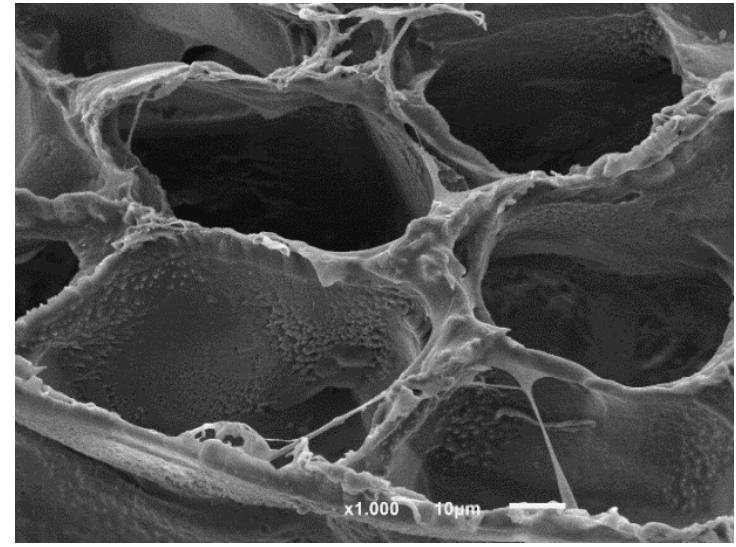
Figure 11. Cell morphology of MC3T3_E1 pre-osteoblastos seeded on PLLA.